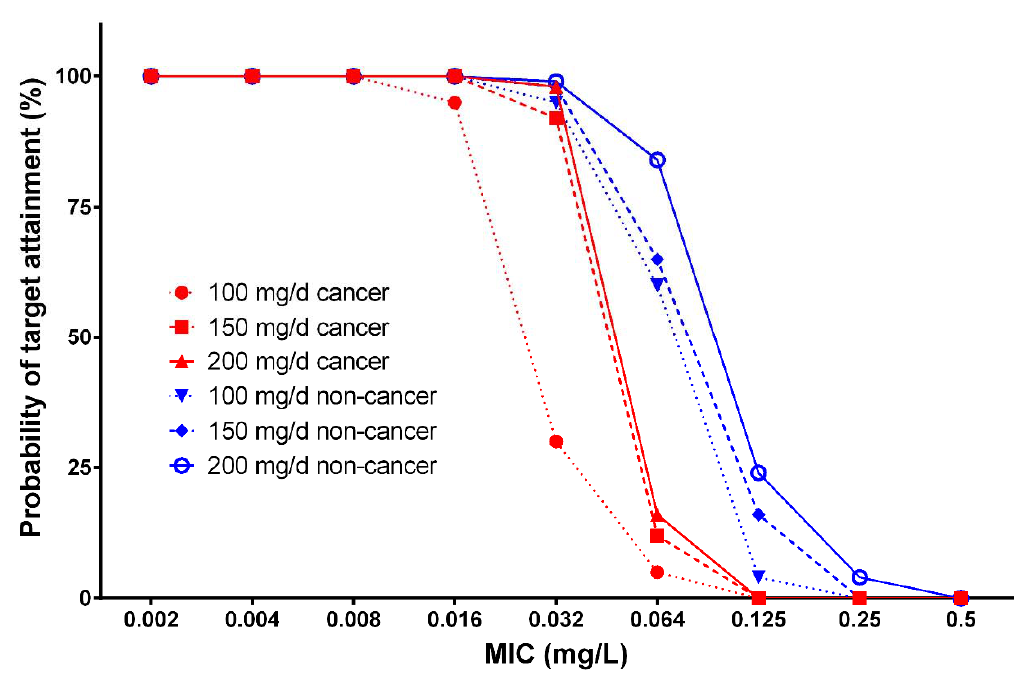
Figure 4. Probability of target attainment, using an AUC 0–24 /MIC target of 3000 for non- parapsilosis Candida spp. for different micafungin dosing regimens in patients with and without cancer. Table 3. MIC breakpoints for Candida spp. and C. parapsilosis indicating 90% PTA for various micafungin doses in patients weighing 50, 70, and 100 kg.